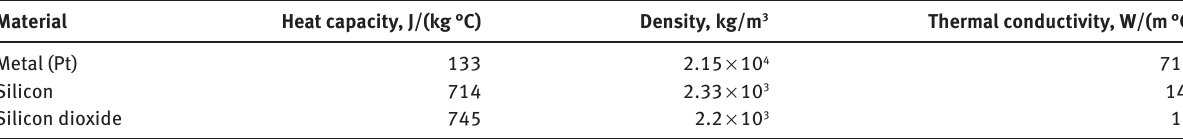
Table 1: Heat capacity, density, and thermal conductivity of the materials used for calculation [70].